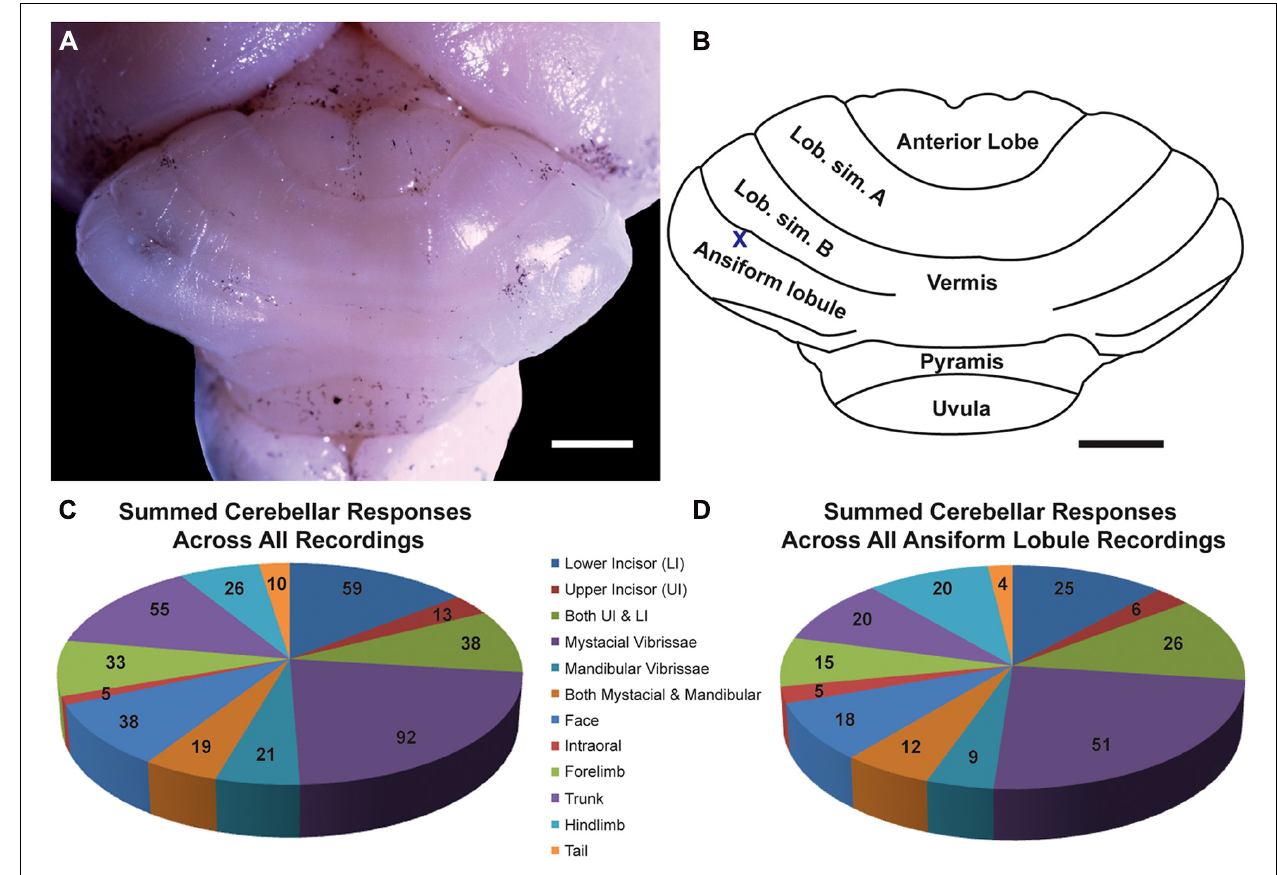
FIGURE 1 |The naked mole-rat cerebellum is shown in a dorsal view, both in a low-magnification image (A) and schematized illustration (B) to delineate the principal lobules (rostral is up; nomenclature follows; Marzban etal., 2011). A toluidine blue dye injection within the ansiform lobule (A) is also represented as an X within the schematized illustration (B) . Data obtained from this animal is shown in Figure 5 . Animal #030409. Scale bars: 1 mm for both (A,B) . (C) A total of 274 recording sites (summed across all folia and across all animals) yielded responses to somatosensory stimuli, the majority of which included responses to stimulation of the incisors (59 for the lower incisor alone, 13 for the upper incisor alone, and 38 for a receptive